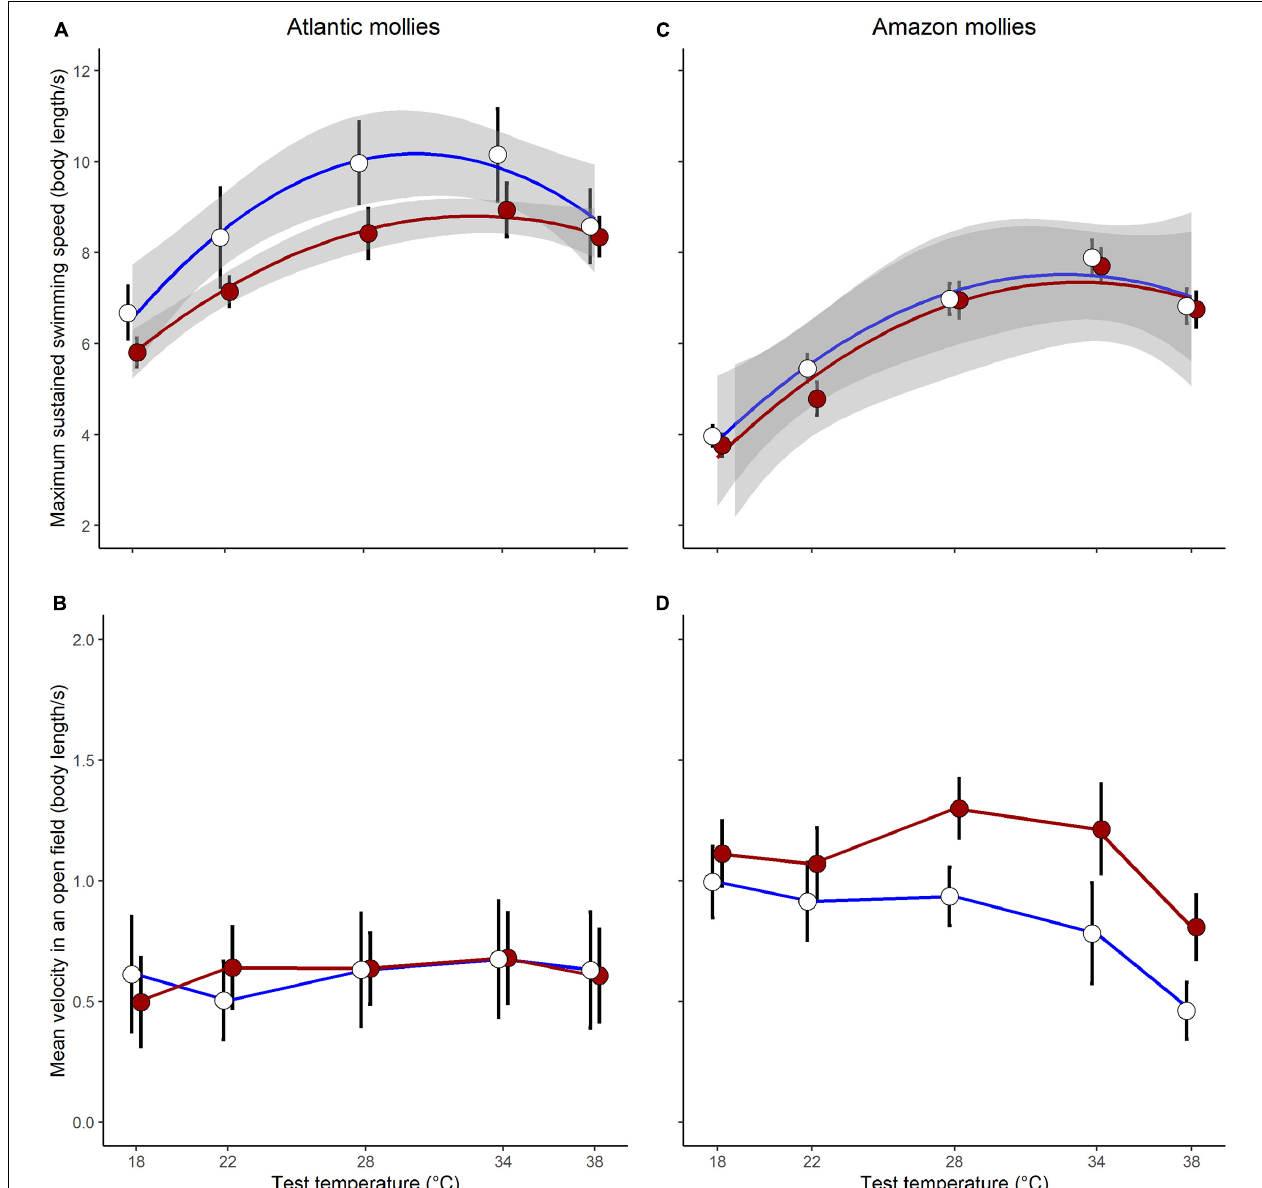
FIGURE 2 | Plasticity in locomotor traits. Sexually reproducing Atlantic mollies exhibited developmental plasticity in swimming performance (A) but not open field movement (B) in response to different developmental thermal environments. Clonal amazon mollies showed no developmental plasticity in swimming performance (C) but did in open field movement (D) . Shown are means ± SE; N = 26, 24 for cold, hot Atlantic mollies, respectively; and N = 28, 31 for cold, hot Amazon mollies, respectively. The gray bands in panel (A,C) indicate the 95% CI from the fitted quadratic curve; we were unable to fit similar curves to the movement data as it did not follow a typical quadratic